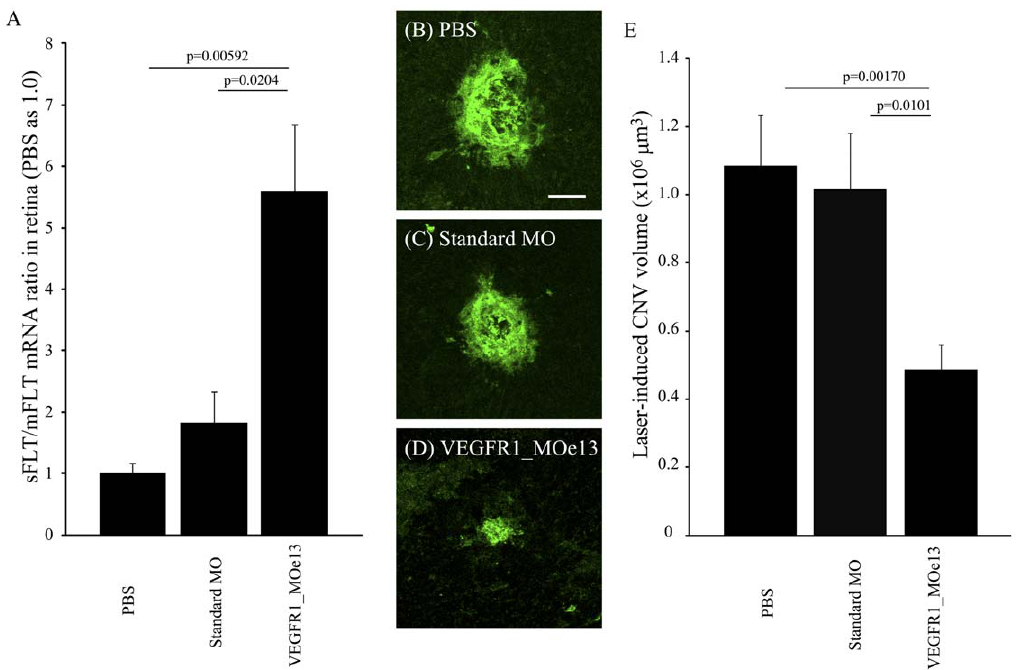
Figure 3. VEGFR1_MOe13 inhibits laser-induced CNV in vivo. a. sFlt/mFlt mRNA ratio in the retina treated with PBS, Standard_MO and VEGFR1_MOe13 (n=4). Representative images of laser CNV injected with b PBS, c Standard_MO and d VEGFR1_MOe13 designed to target the murine